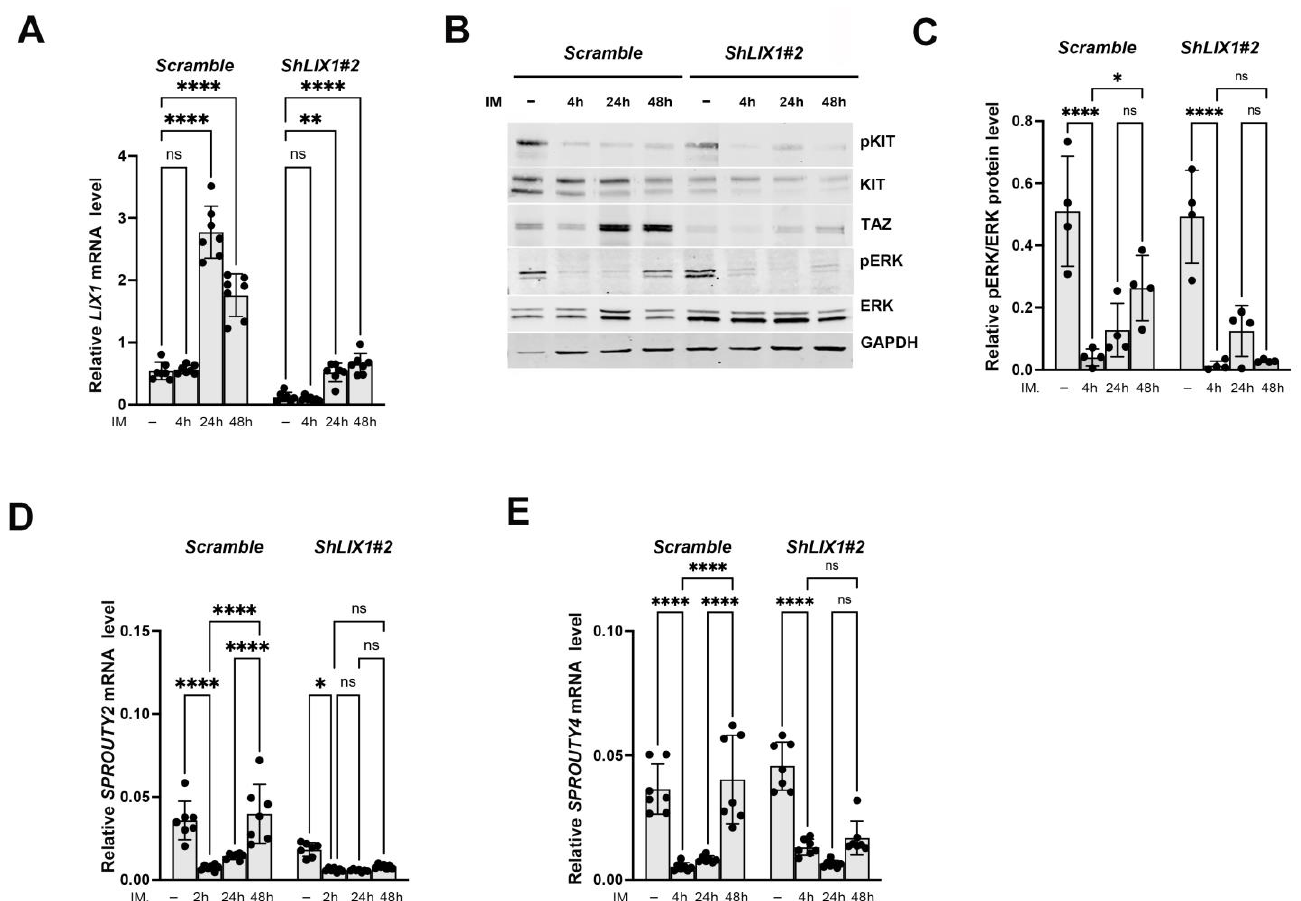
Figure 3. LIX1 promotes MAPK-signaling reactivation in imatinib-treated GIST cells. Control (GIST- T1- Scramble ) or GIST-T1 cells in which LIX1 was silenced with shRNAs (GIST-T1- ShLIX1#2 ) were cultured in the absence (-) or the presence of 0.5 µ M imatinib (IM) and collected after 4, 24, and 48 h. ( A ) RT-qPCR analysis of LIX1 transcript levels. Data were normalized to the mean HMBS and YWHAZ expression. Values are the mean ± SEM of seven independent experiments. ** p < 0.01, **** p < 0.0001; ns, non-significant (one-way ANOVA followed by Tukey’s multiple comparisons test). ( B ) Western blot analysis. Membranes were probed with antibodies against KIT, ERK, and AKT proteins and their phosphorylated forms. Equal loading was verified by GAPDH expression. ( C ) Quantification of MAPK-signaling activity. Values were calculated as the ratio between phosphorylated and total ERK signals after normalization to GAPDH levels. Values are the mean ± SEM of four independent experiments. * p < 0.05, **** p < 0.0001; ns, non-significant (one-way ANOVA followed by Tukey’s multiple comparisons test). ( D , E ) RT-qPCR analysis of SPROUTY2 ( D ) and SPROUTY4 ( E ) transcript levels in GIST-T1- Scramble and GIST-T1- ShLIX1#2 cells cultured in the absence (-) or presence of 0.5 µ M imatinib. Data were normalized to the mean HMBS and YWHAZ expression. Values are the mean ± SEM of seven independent experiments. * p < 0.05, **** p < 0.0001; ns, non-significant (one-way ANOVA followed by Tukey’s multiple comparisons